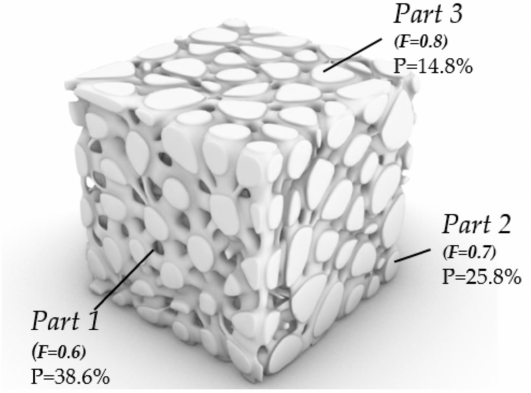
Figure 23. Structure with different porosity in different